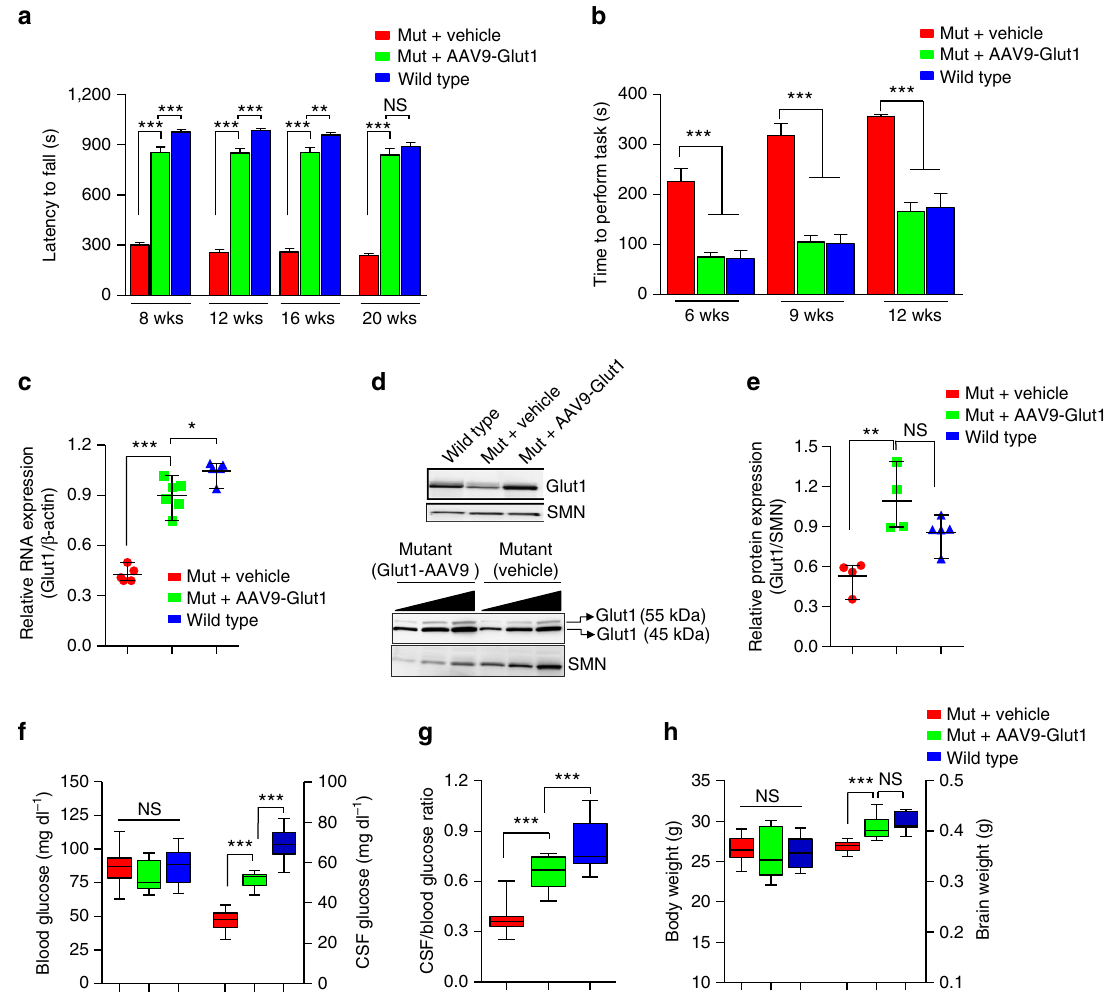
Figure 4 | Early Glut1 repletion mitigates the Glut1 DS disease phenotype in model mice. ( a , b ) Systemically administered AAV9-Glut1 results in a significant improvement in motor performance on (a) the rotarod and (b) in a vertical pole assay. N Z 16 mice in each cohort. ( c ) Quantification of RNA (endothelial and astrocytic) expression in brain tissue of controls and mutants treated on PND3. N Z 5 mice in each cohort. ( d ) Representative western blot analysis of Glut1 protein in brain tissue of Glut1 DS mutants following repletion of the protein. The lower set of blots demonstrates that repletion of Glut1 by the virus raises the 45kDa (astrocytic) as well as 55kDa (endothelial) differentially glycosylated isoforms of the protein. ( e ) Quantitative assessment of total protein (astrocytic and endothelial) in treated mutants and control mice. N Z 4 mice each. ( f , g ) CSF, but not blood glucose levels are significantly increased in mutants treated with AAV9-Glut1; a corresponding increase in the ratio of CSF:Blood glucose was assessed. N Z 13 mice in each cohort. ( h ) Microcephaly is ameliorated in mutants restored for Glut1 protein. N Z 7 mice in each cohort. Note: *, **, ***, P o 0.05, P o 0.01, P o 0.001 respectively, one-way ANOVA for each panel in the